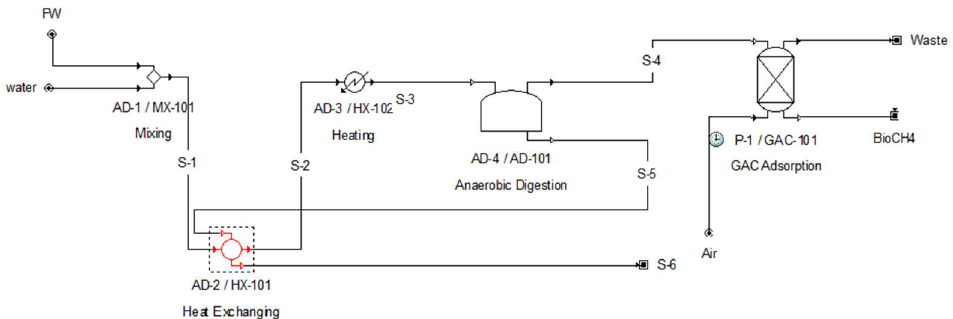
Figure 1. Food waste (FW)-to-green methane (GM) process flowsheet created in SuperPro Designer.